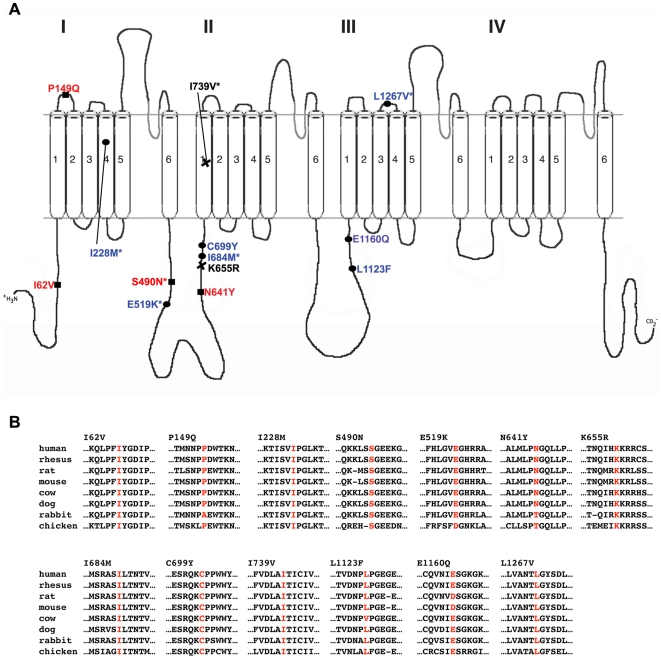

SCN9A is mutated in multiple patients with febrile seizures (FS) and Dravet syndrome.(A) Phenotypic profile and secondary structure locations of all variants found in SCN9A. Red text, variants in FS patients; blue text, variants in Dravet syndrome patients; black text, variants in both phenotypes; *variants also found in controls. (B) Amino acids from the UCSC genome browser (http://genome.ucsc.edu/) showing conservation across 8 species for FS and Dravet syndrome variants (red) found in SCN9A. The human Nav1.7 protein shares identity of 97% to rhesus, 92% to rat, 92% to mouse, 94% to cow, 94% to dog, 93% to rabbit, and 75% to chicken.